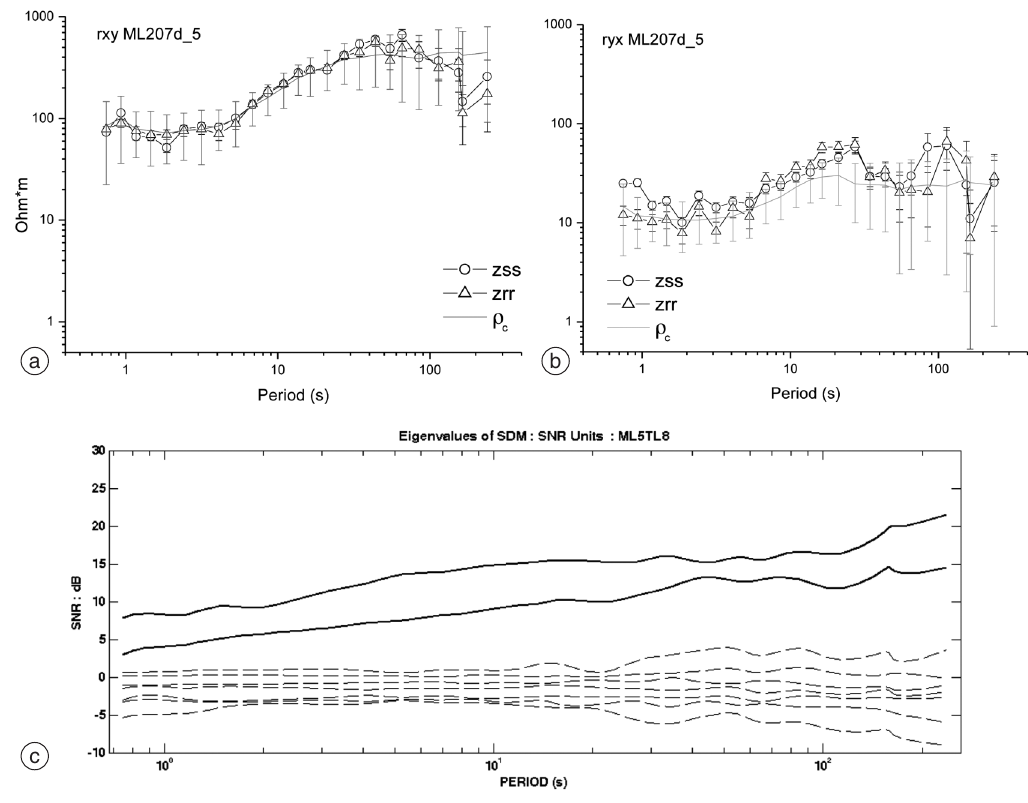
Fig. 6a-c. Comparison between the apparent resistivity curves estimate for the MN site computed with robust single station method ( zss curve), using TR site as a reference ( zrr curve) for xy component (a) and yx compo- nent (b). (c) Eigenvalues of SDM for MN site: the two dominant eigenvalues are plotted with solid